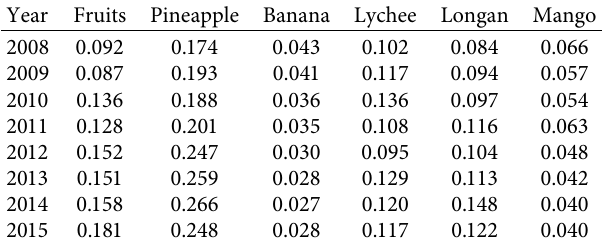
Table 3: The market share of Hainan’s exported fruits (%). Year Fruits Pineapple Banana Lychee Longan Mango